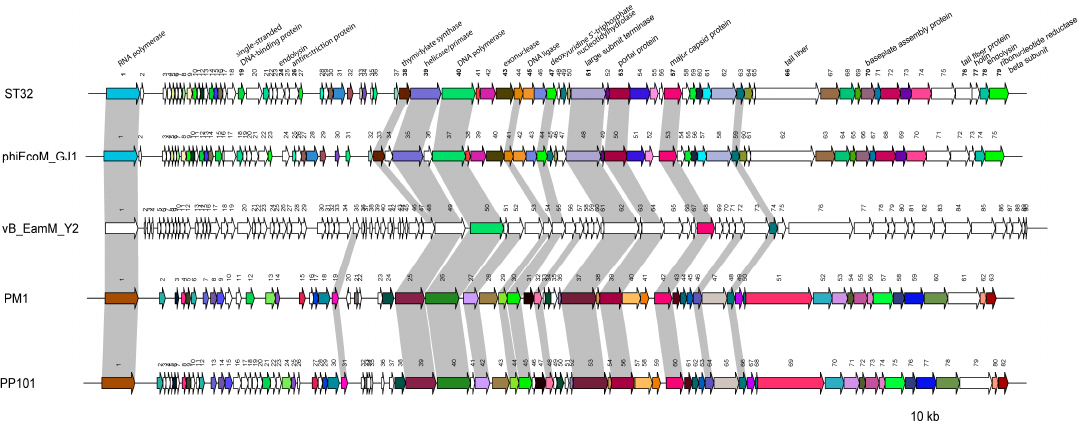
Figure 4. Schematic representation of the genomic organization of phage ST32 compared to phages phiEcoM-GJ1, vB_EamM-Y2, PM1, and PP101. Each line represents a different phage genome and each arrow represents an ORF. Arrows of the same color indicate ORFs that share more than 80% identity. White arrows indicate that the identity is less than 80% or there is no homologous putative protein. Gray shading indicates vB_EamM-Y2 phage ORFs sharing more than 70% with that of other aligned phages.